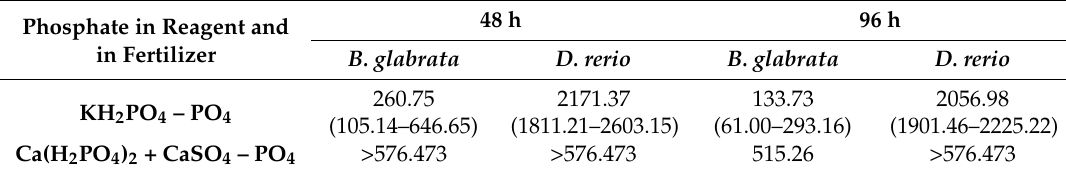
Table 5. Comparison between the lethal concentrations (LC50s) obtained in different assays with phosphate present for the reagent and the commercial fertilizer for the B. glabrata snail and the D. rerio fish (units: mg · L − 1 ). Values in brackets represent 95% confidence intervals.